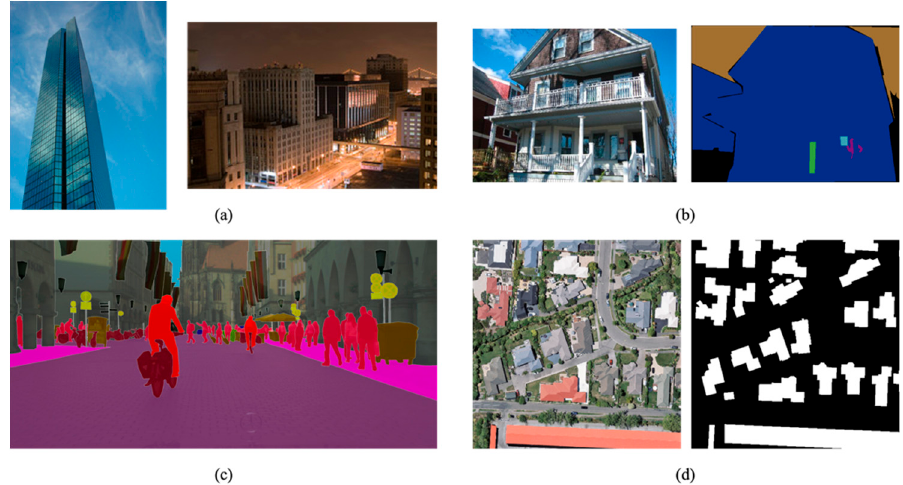
Figure 1. Di ff erent building-related datasets. ( a ) ImageNet dataset, training VGGNet and ResNet. ( b ) ADE20K dataset, training PSPNet. ( c ) Cityscapes, training SegNet and DeepLab. ( d ) WHU Building Dataset.